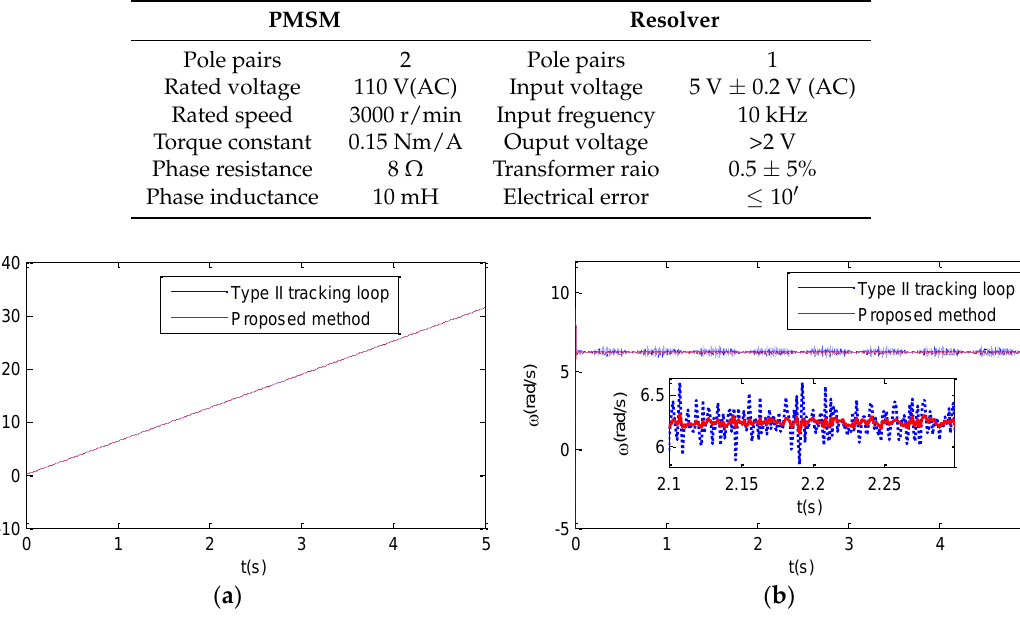
Figure 11. Experimental platform. Table 3. PMSM and resolver parameters.